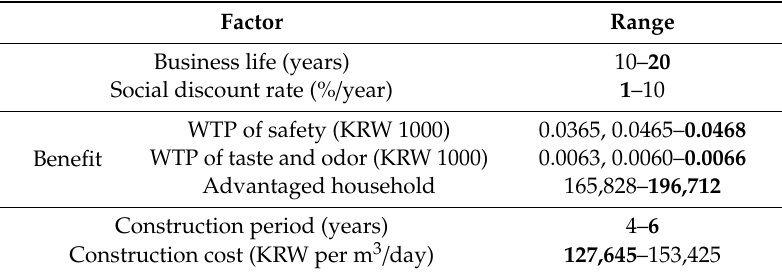
Table 9. Summary of basic assumptions for CBA.